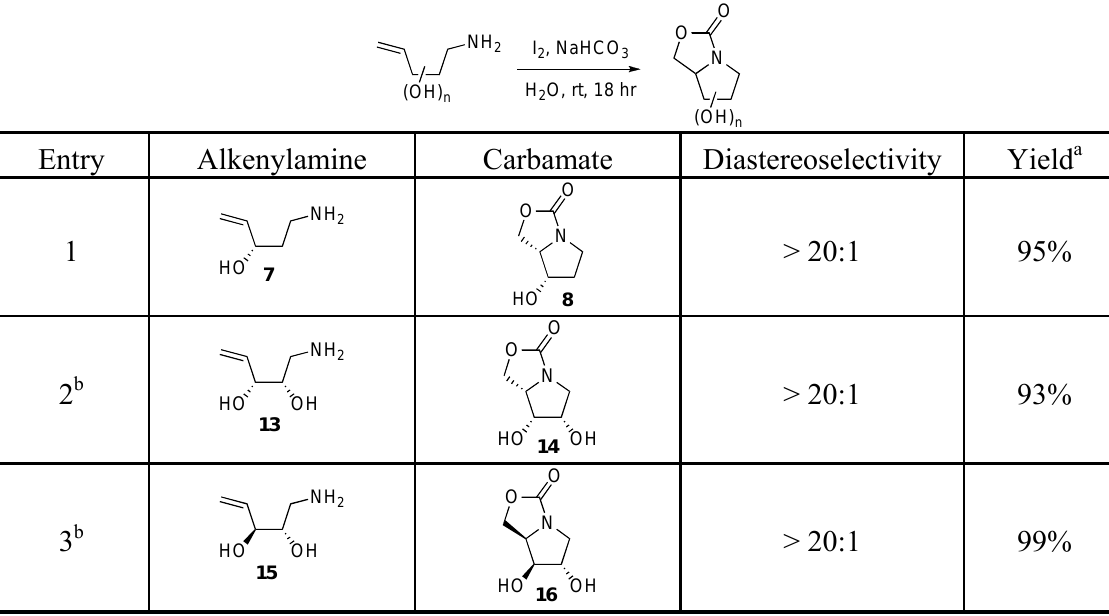
Table 1. Diastereoselectivity of iodine-promoted carbamate annulations.